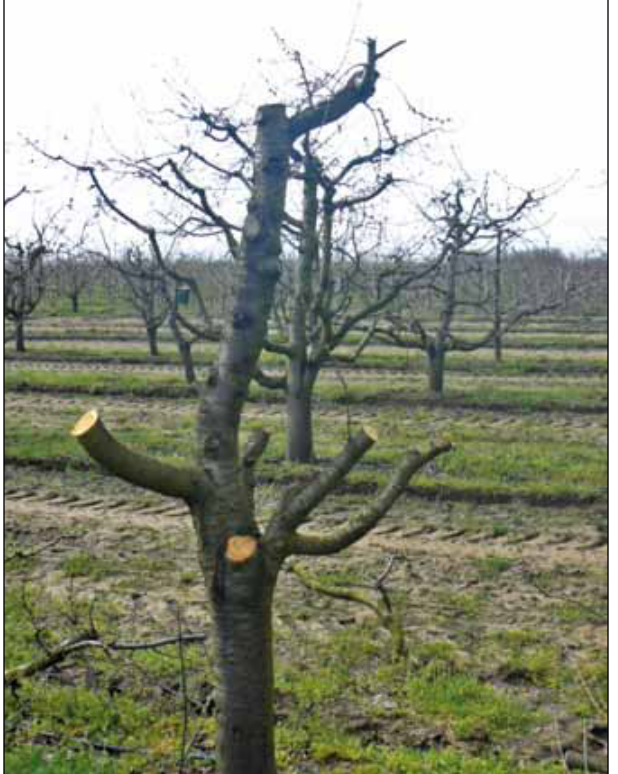
Photo 2 : Total rejuvenation pruning on sour cherry